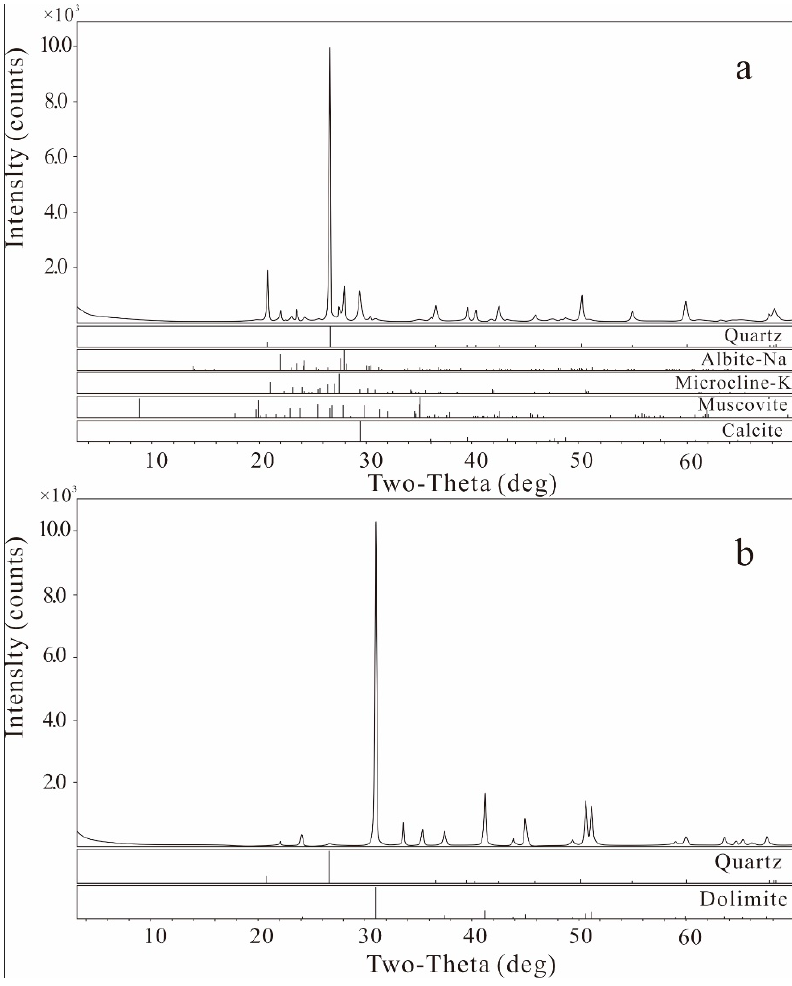
Figure 3. Energy spectrum analysis chart corresponding to cores ( a ) R1 and ( b ) R2. Table 3. Experimental scheme of